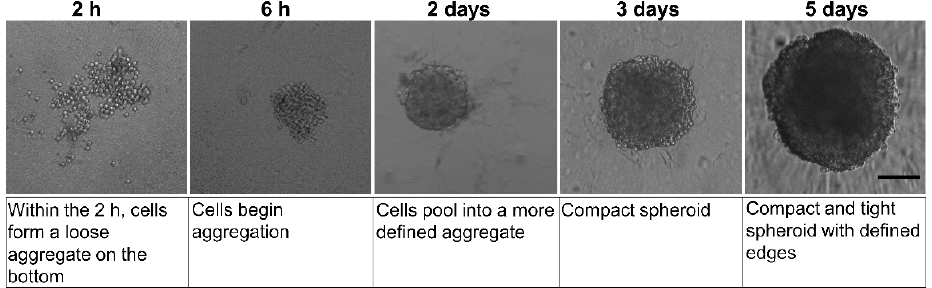
Figure 1. Morphology analysis by phase-contrast microscopy of the D384 spheroid formation over a 5-day period in 96-well spheroid microplate. At 2–6 h after seeding, D384 cells appeared without total compactness. On day 5, complete D384 spheroid formation was observed and this time point was chosen as the starting point for drug treatments. Scale bar: 100 µm.